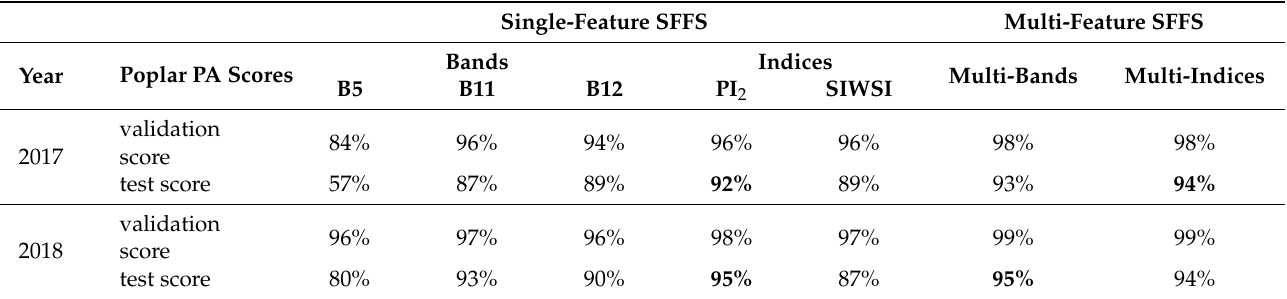
Table 4. Poplar PA scores obtained using the 10 best feature subsets based on SFFS in the single- and multi-feature configurations. The test score gives the poplar PA after prediction based on the test set (50% of reference data). The validation score is based on a 5-fold CV applied on the training set (50% of reference data used for feature selection). The highest test scores are highlighted in